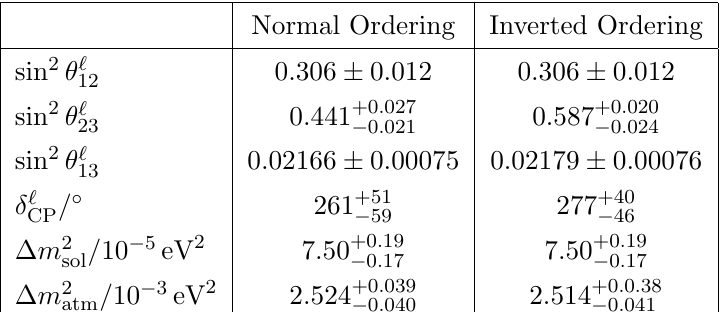
Table 1. Three-(cid:13)avour oscillation parameters from the global (cid:12)t in ref. [42]. The results in the second and third columns refer to the Normal and the Inverted Orderings, respectively. The notation has been chosen such that (cid:1) m 2 (cid:1) m 2 (cid:17) m 2 (cid:0) m 2 for IO. The errors reported correspond to the 1 (cid:27) atm (cid:23) 2 (cid:23) 3